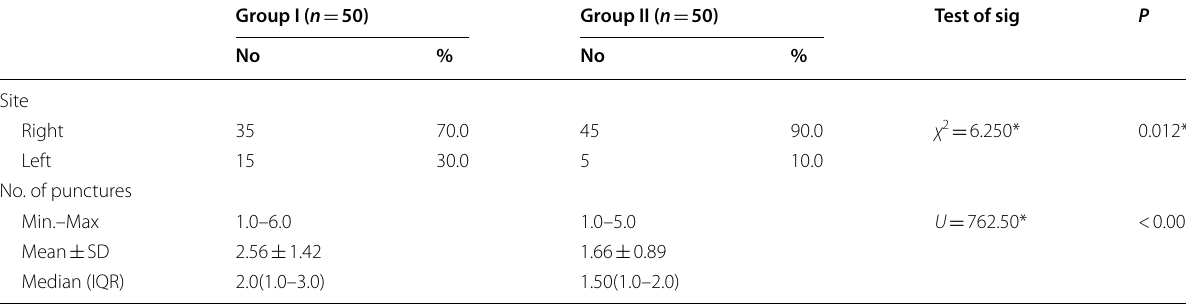
Table 4 Comparison between the two studied groups according to site and no. of punctures